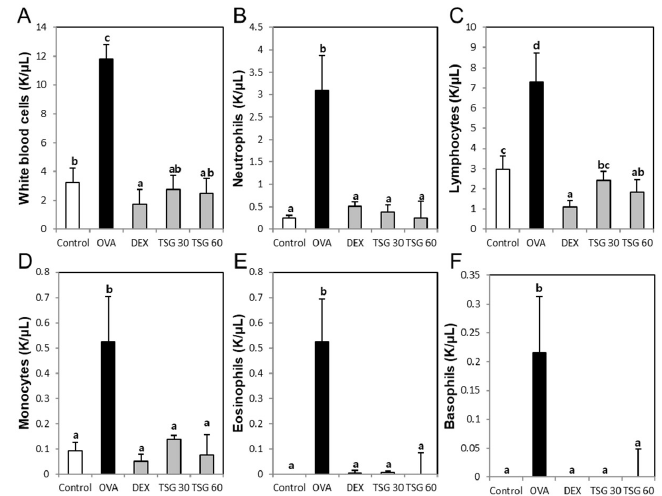
Figure 3. The effects of TSG on the population of inflammatory cells in the blood. ( A ) white blood cell, ( B ) neutrophil, ( C ) lymphocyte, ( D ) monocyte, ( E ) eosinophil, and ( F ) basophil were analyzed by the HEMAVET 950. Group data are expressed as means ± SD for five mice per group. a, b, c, and d: The means not sharing a common letter are significantly different between groups at p < 0.05 as measured by one-way ANOVA with Duncan’s multiple-range test.